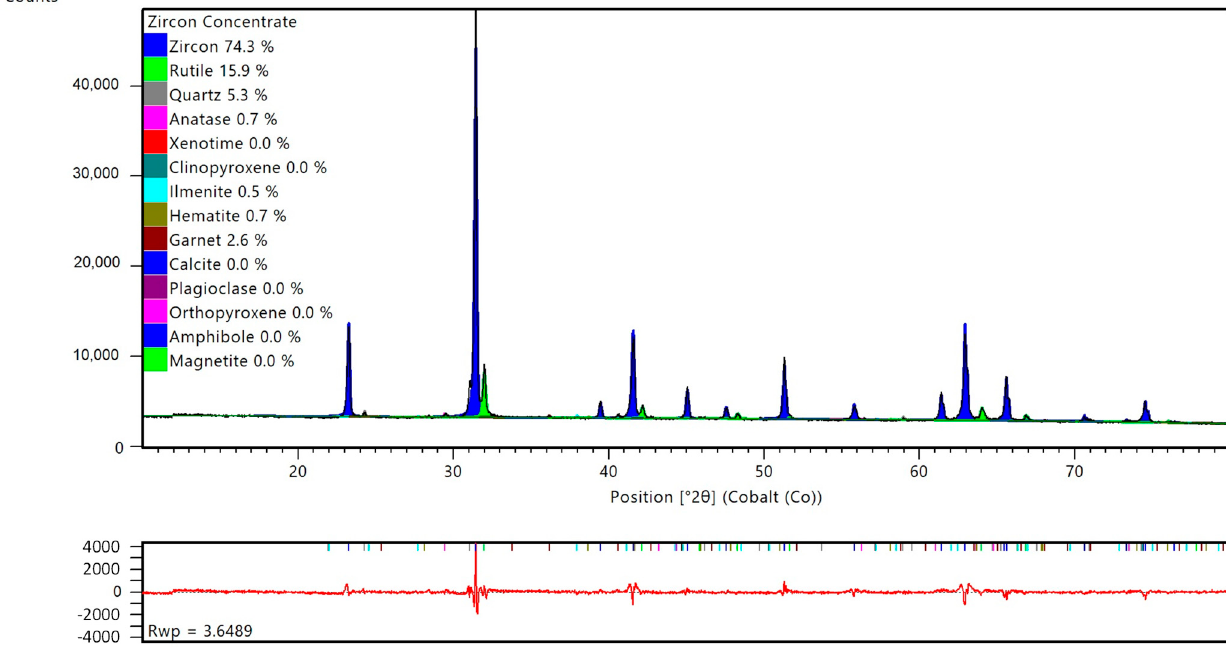
Figure 8. Typical zircon concentrate. Rietveld quantification ( top ) including difference plot between measured and calculated profiles as well as the R wp ( bottom ).